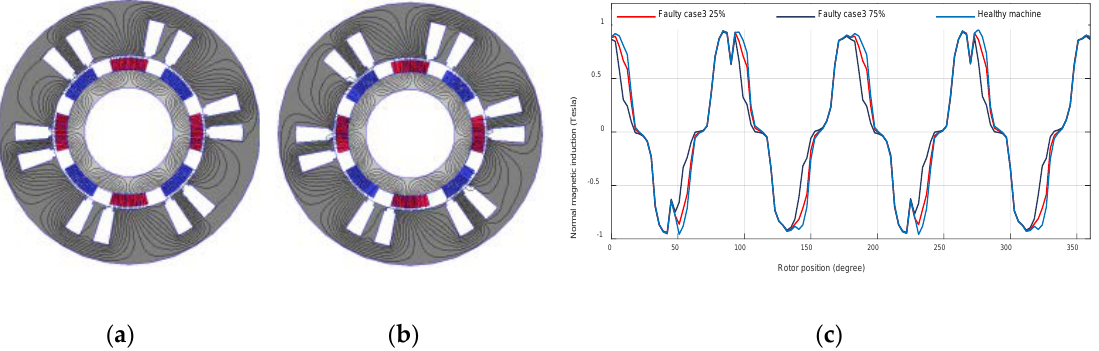
Figure 8. Faulty case 3: ( a ) Magnetic field under 25%; ( b ) magnetic field under 75%; ( c ) airgap magnetic flux density.